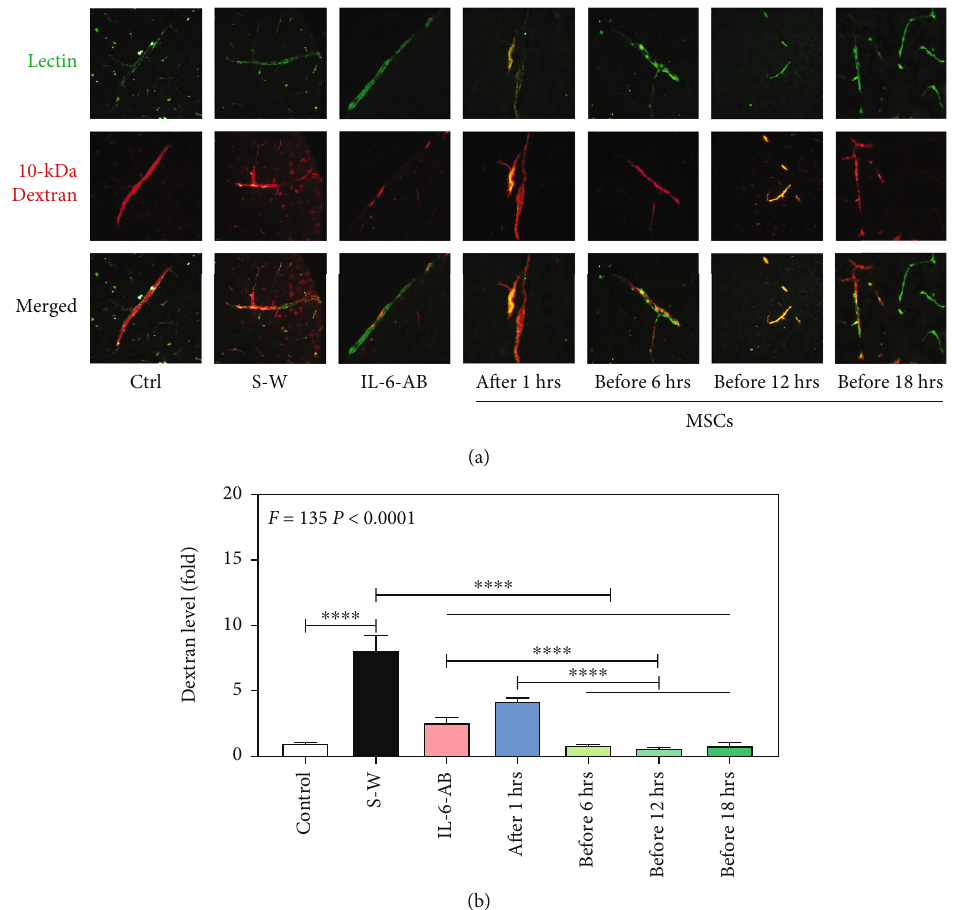
Figure 1: UC-MSCs alleviated extravascular dextran level at di ff erent time points induced by surgical wound in mice. (a) The blood vessels were showed green at the fi rst line, and dextran was showed red at the second line. The brain section of control group (the fi rst column), the S-W (surgical wound group) after 6 hours (the second column), IL-6-AB after surgical wound (the third column), UC-MSCs at 1 hour after surgical wound (the fourth column), UC-MSCs at 6 hours (the fi fth column), 12 hours (the sixth column), and 18 hours before surgical wound (the seventh column). The red spots of nonoverlap showed in the third line indicate the dextran outside the BMECs. N = 6 in each group. Scale bar, 50um. (b) Fluorescent quantitation showed that di ff erent time points of UC-MSCs and IL-6-AB decreased extravascular level of 10 kDa dextran outside the BMECs compared with the S-W group (black bar) after surgical wound, and the most e ffi cient level is the administration of UC-MSCs before surgical wound. N = 6 in each group ( ∗ for comparing with control, ∗∗ p < 0 : 01 , ∗∗∗ p < 0 : 001 , ∗∗∗∗ p < 0 : 0001